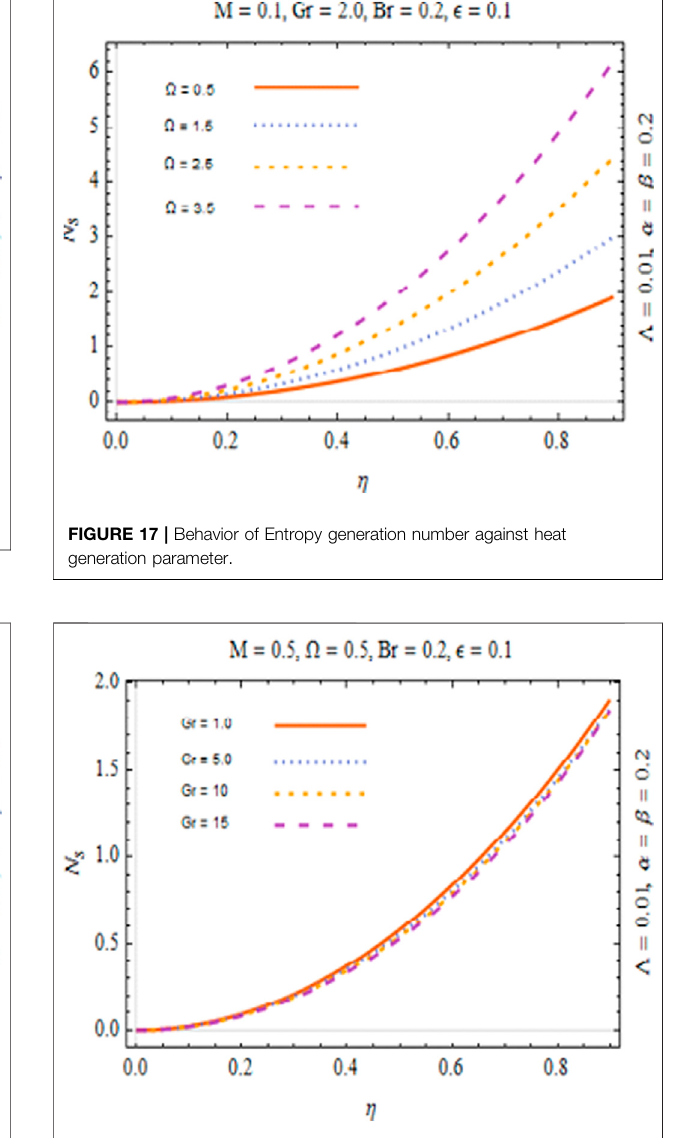
FIGURE 16 | Behavior of Entropy generation number against Brinkman number.